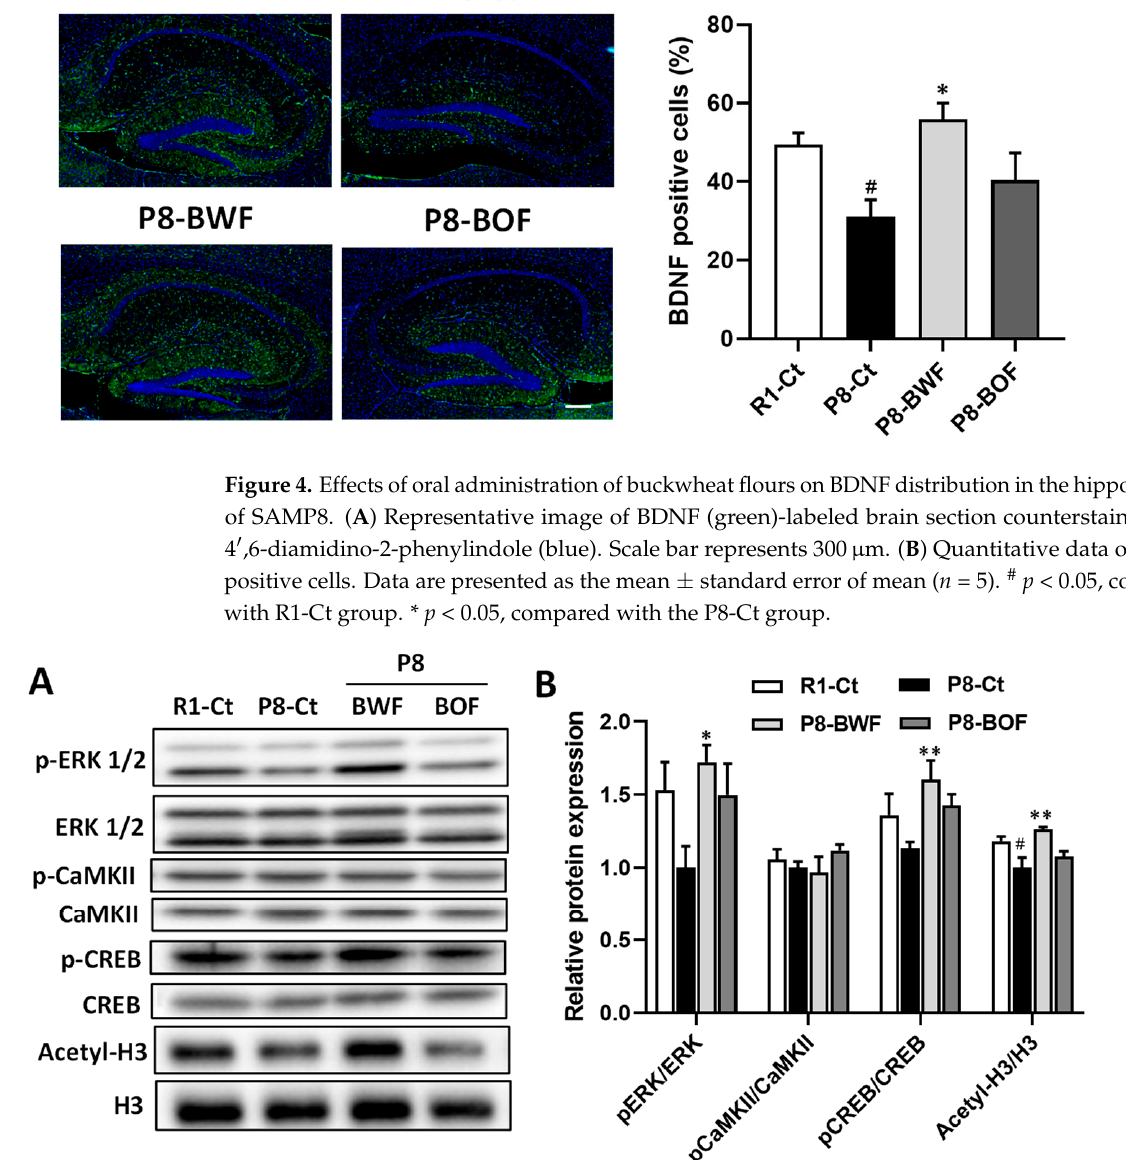
Figure 5. Effects of oral administration of buckwheat flours on phosphorylation of ERK, CaMKII, and CREB and acetylation of histone H3 in the hippocampus of SAMP8 mice. ( A ) Representative image of the Western blot. ( B ) Densitometric data are expressed as the ratio of phosphorylated proteins to total proteins, and the ratio of acetyl histone H3 to total histone H3. Each bar is expressed as the mean ± standard error of mean ( n = 5). # p < 0.05, compared with R1-Ct group. * p < 0.05, ** p < 0.01 vs. the P8-Ct group. ERK, extracellular signal-regulated kinase; CaMKII, calcium/calmodulin-dependent protein kinase II; CREB, cAMP response element-binding protein.